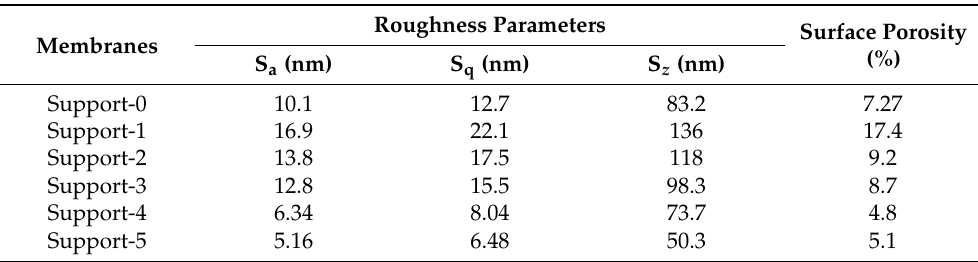
Table 4. Surface roughness parameters and surface porosity of CA/PVDF membranes obtained from AFM and SEM